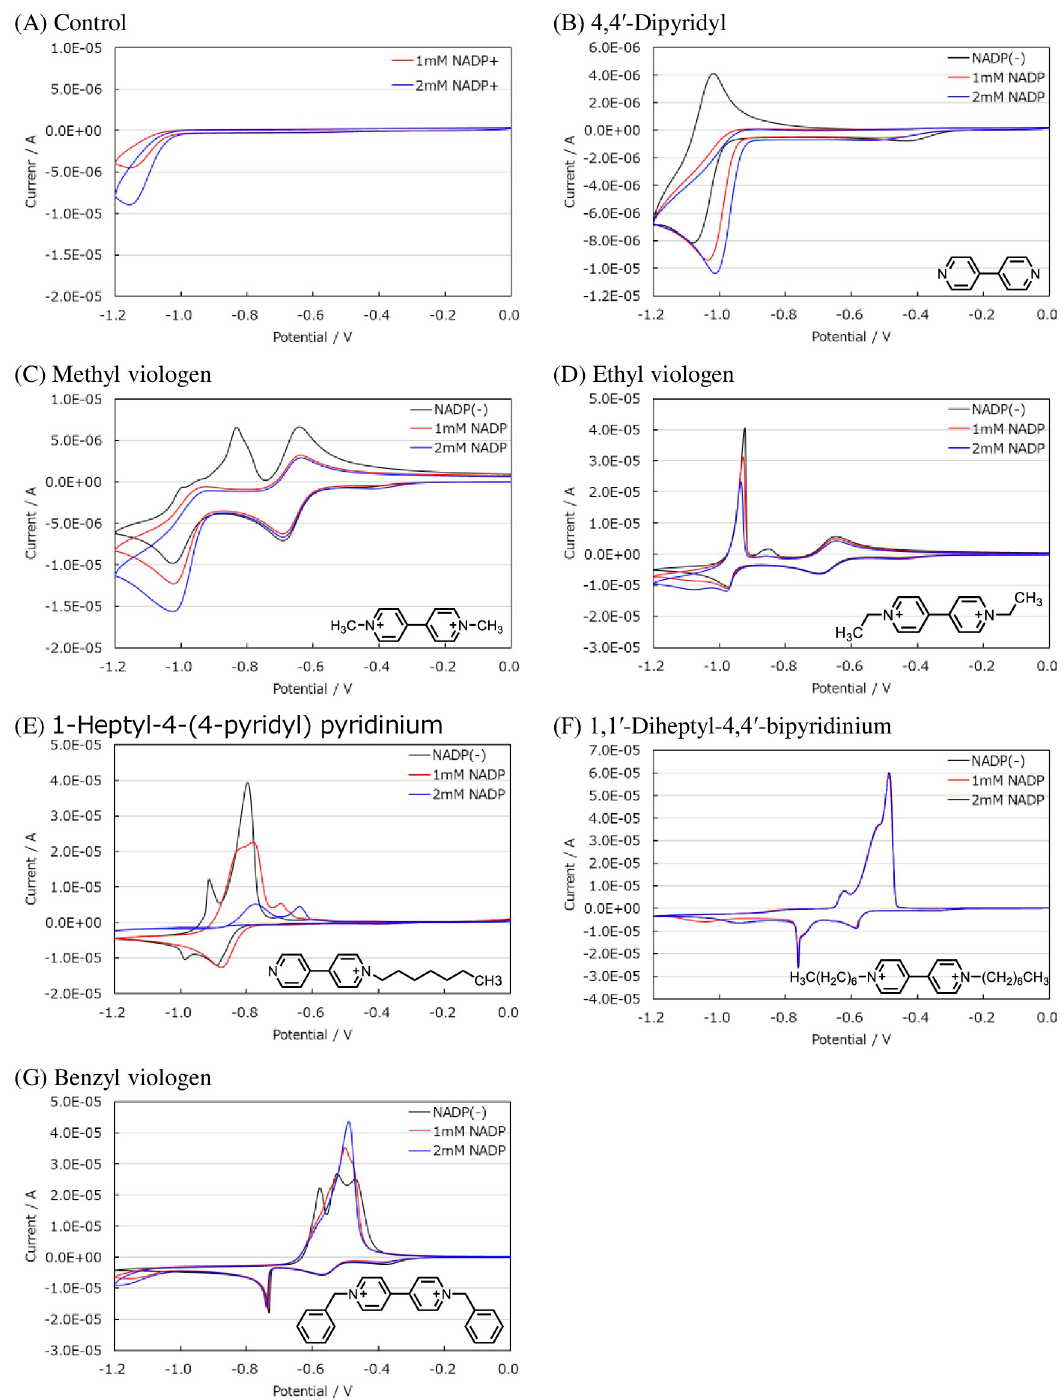
Fig 2. The cyclic voltammograms of 1 mM bipyridine derivatives in PBS (pH 7.4). Black line: the absence of NADP + . Red line: the presence of 1 mM NADP + . Blue line: the presence of 2mM NADP + . Potential scan rate, 50 mV/s. (A) Control (none), (B) 4,4 0 - Dipyridyl, (C) Methyl viologen, (D) Ethyl viologen, (E) 1-Heptyl-4-(4-pyridyl) pyridinium (F) 1,1 0 -Diheptyl-4,4 0 -bipyridinium, (G) Benzyl viologen. These experiments were repeated three times with similar results.